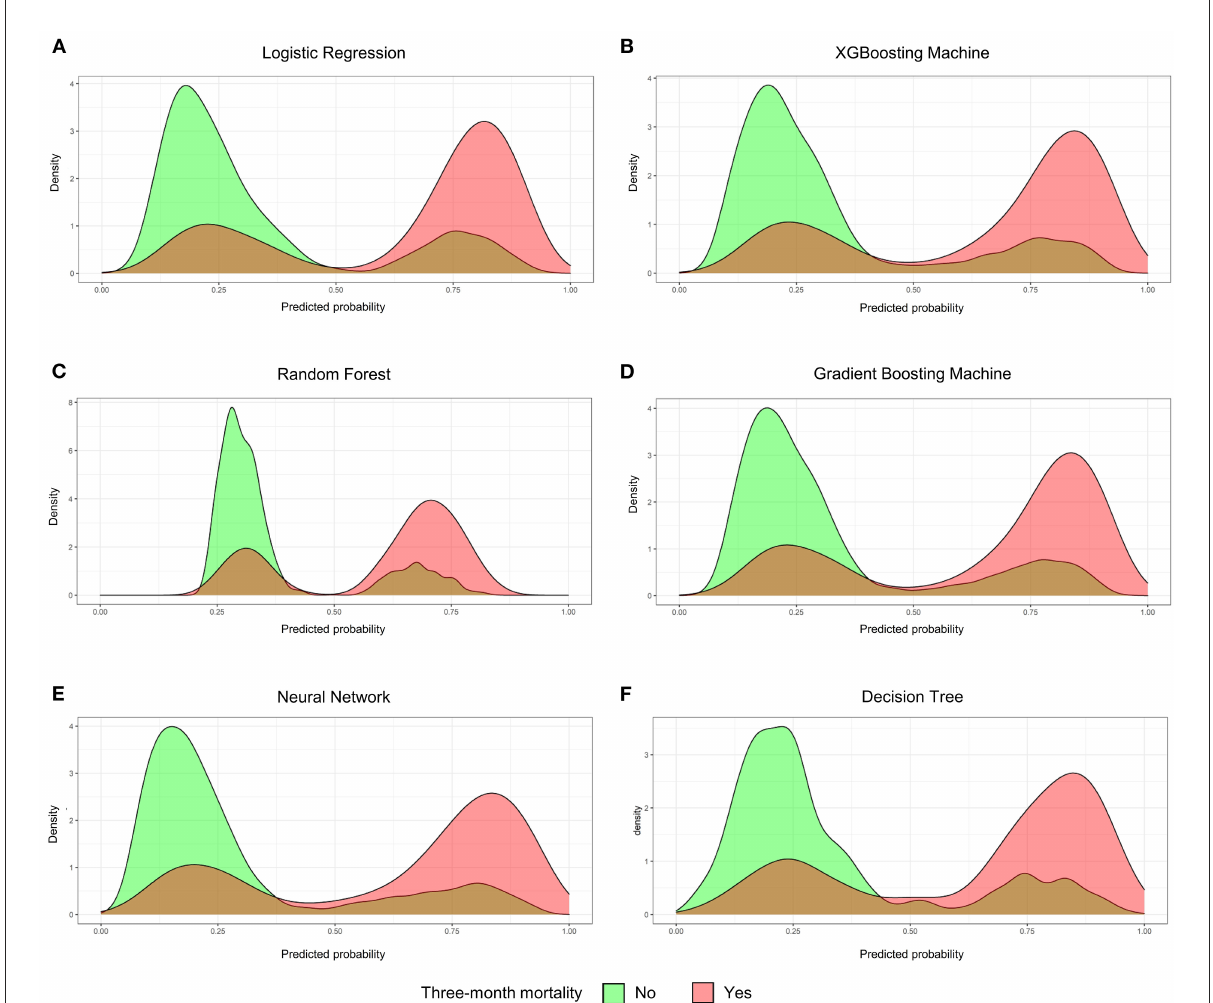
FIGURE3 The probability curves. (A) Logistic Regression; (B) XGBooting Machine; (C) Random Forest; (D) Gradient Boosting Machine; (E) Neural Network; (F) Decision Tree. The green group indicates patients were alive for above 3 months and the red group indicates patients were died at or within 3